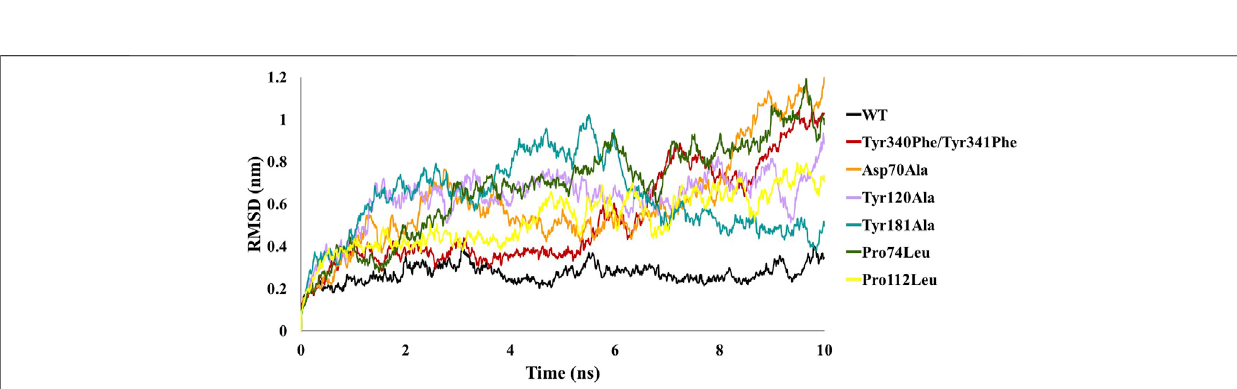
FIGURE 2 | Comparative backbone root mean square deviation (RMSD) analysis of wild-type (WT) structural complex and constructed mutant complexes.